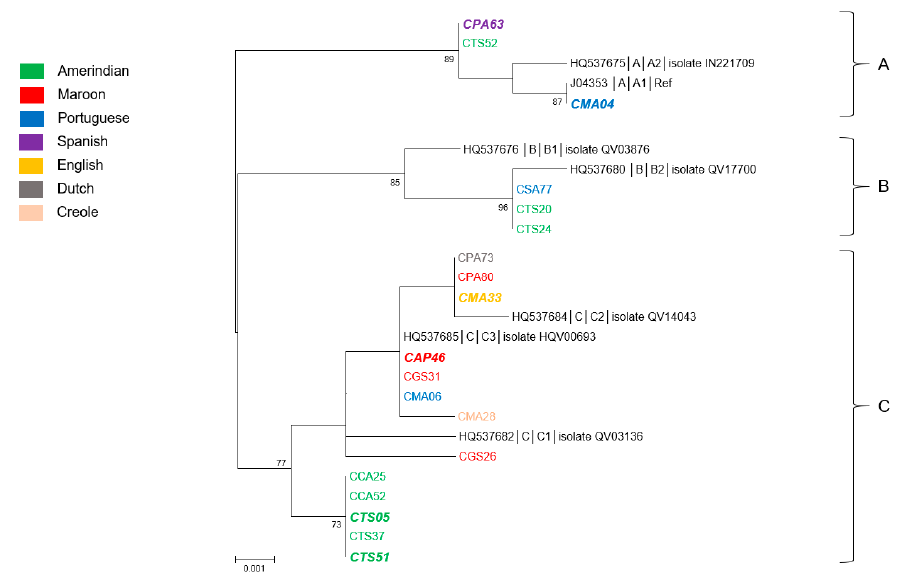
Figure 3. Phylogenetic tree of HPV31 variants from French Guiana. Maximum likelihood phylogenetic tree of HPV31 variants based on 741 bp of E6 and E7 concatenated sequences. Three clusters were identified as lineages A, B, and C. Only bootstrap values above 70% are represented in the branches. The tree is drawn to scale with branch lengths measured in the number of substitutions per site. Newly generated sequences, here identified by their IDs, are color-coded according to the mother tongue of the women from whom they were obtained. Oversized sequences in bold and in italics are those obtained from women with an abnormal cytology (either ASCUS, ASC-H, LSIL, HSIL or, glandular anomalies).